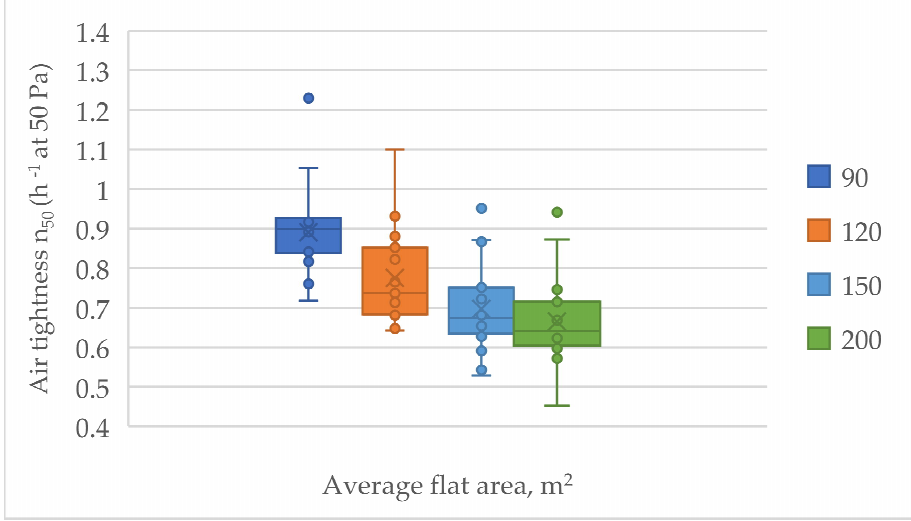
Figure 3. Airtightness measurement distribution for the flats of different floor areas. The recorded results show that the values of airtightness of the flats with the same floor area can vary in a large range reaching the difference up to two times. The analysis of airtightness values of the flats of different floor areas revealed that the statistic average of results gradually decreases with the increase of the floor area of the flat, but the overall measurement scatter remains almost constant. The comparison of the groups of flats of 90 m 2 and 200 m 2 floor area showed that the average value of airtightness for the flats with larger floor area is 25% smaller. The obtained results can be interpreted as the achievement of better average airtightness measurement result for the flats with a larger floor area and the same time a larger volume. This fact of the better results for larger flats could be explained as a minor defect that has a smaller effect on the general result of the airtightness of the